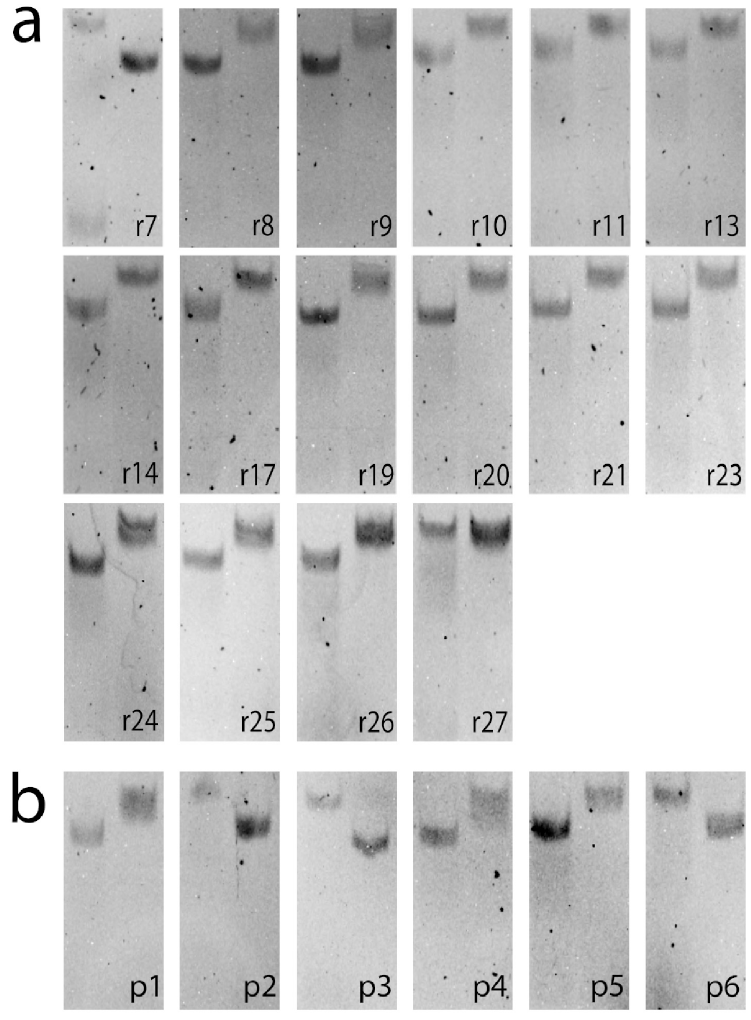
Fig 7. a : Binding site assay of all binding sequences and r27 (a nonbinder control) in the RBM generated dataset. b : Binding site assay of the 6 sequences that make up the sequence space between ThA and test sequence r9. For all gels, Lane 1 shows addition of ThA and lane 2 shows addition of ThD to the thrombin pre-incubated strand (labeled in black). Results are reported in Table 1. As we noticed that sequence r9, which is an exosite-I binder, is only 3 mutations away from ThA, which binds exosite II, we decided to test all six intermediate sequences, labelled as p1-p6 in Table 1. One mutation (Adenine vs. Thymine on site 17) seems to control the exosite bind- ing preference along the mutational path, see Table 1 and S11 Fig. Analysis of the RBM-SU weights confirms that position 17 is particularly relevant on the aptamer sequence: many weights have non-zero values on this site (S12 Fig). To understand if the presence of A on site 17 (rarely encountered in round 8 sequences) is sufficient to guarantee binding to exosite II we specifically design four sequences (r24 to r27) with this feature and log-likelihoods above threshold, see Methods Sec Design of single-loop aptamers with RBM and Table 1. As reported above none of these sequence turns out to bind exosite II (while 3 out of 4 bind exosite I), showing that binding specificity is generally controlled by multiple-nucleotide motifs along the sequence.